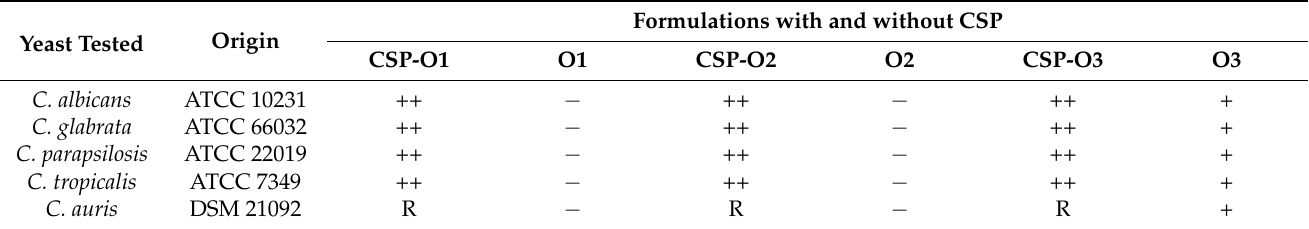
Table 5. Antifungal activity of the CSP formulations with and without CSP.